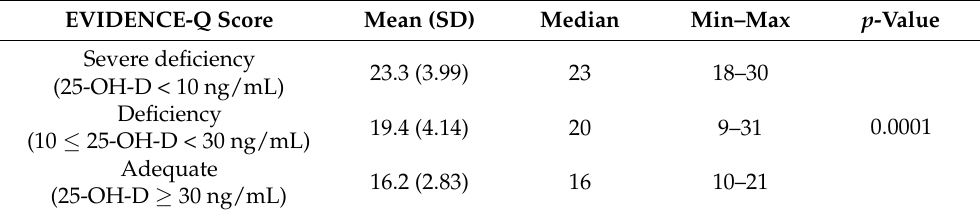
Table 2. EVIDENCE-Q score by vitamin D status, according to the SIOMMS reference values [19]. Data are described as mean value and standard deviation (SD), median value and minimum (min) and maximum (max) values.